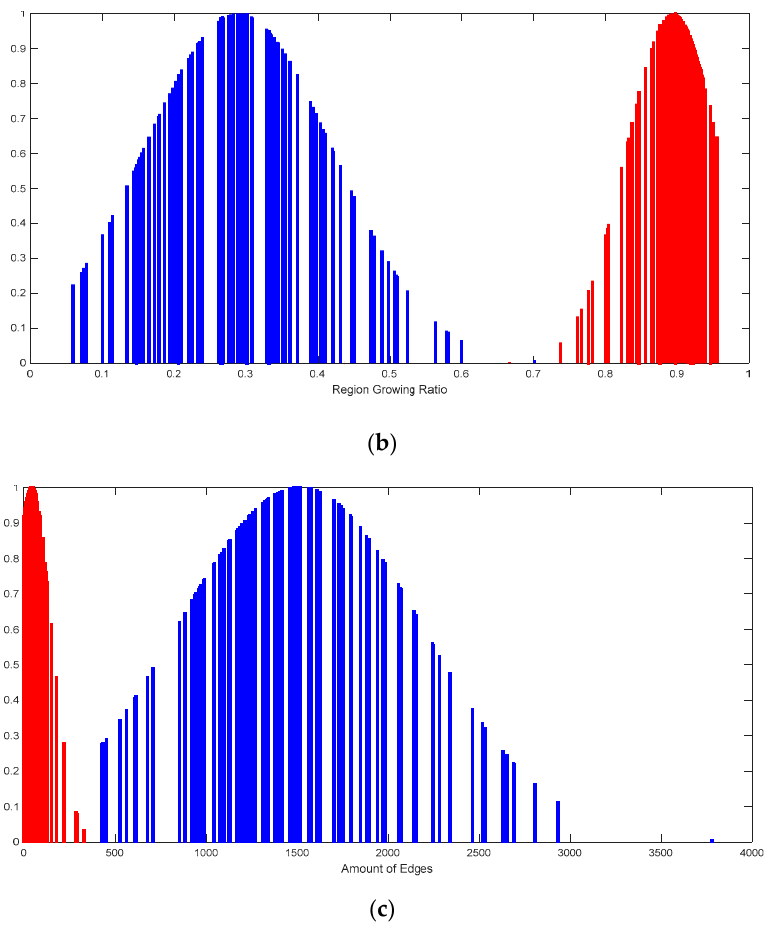
Figure 17. Perpendicular parking training set. ( a ) Scatter plot of features; ( b ) Gaussian distribution of region growing ratio; ( c ) Gaussian distribution of number of edges.